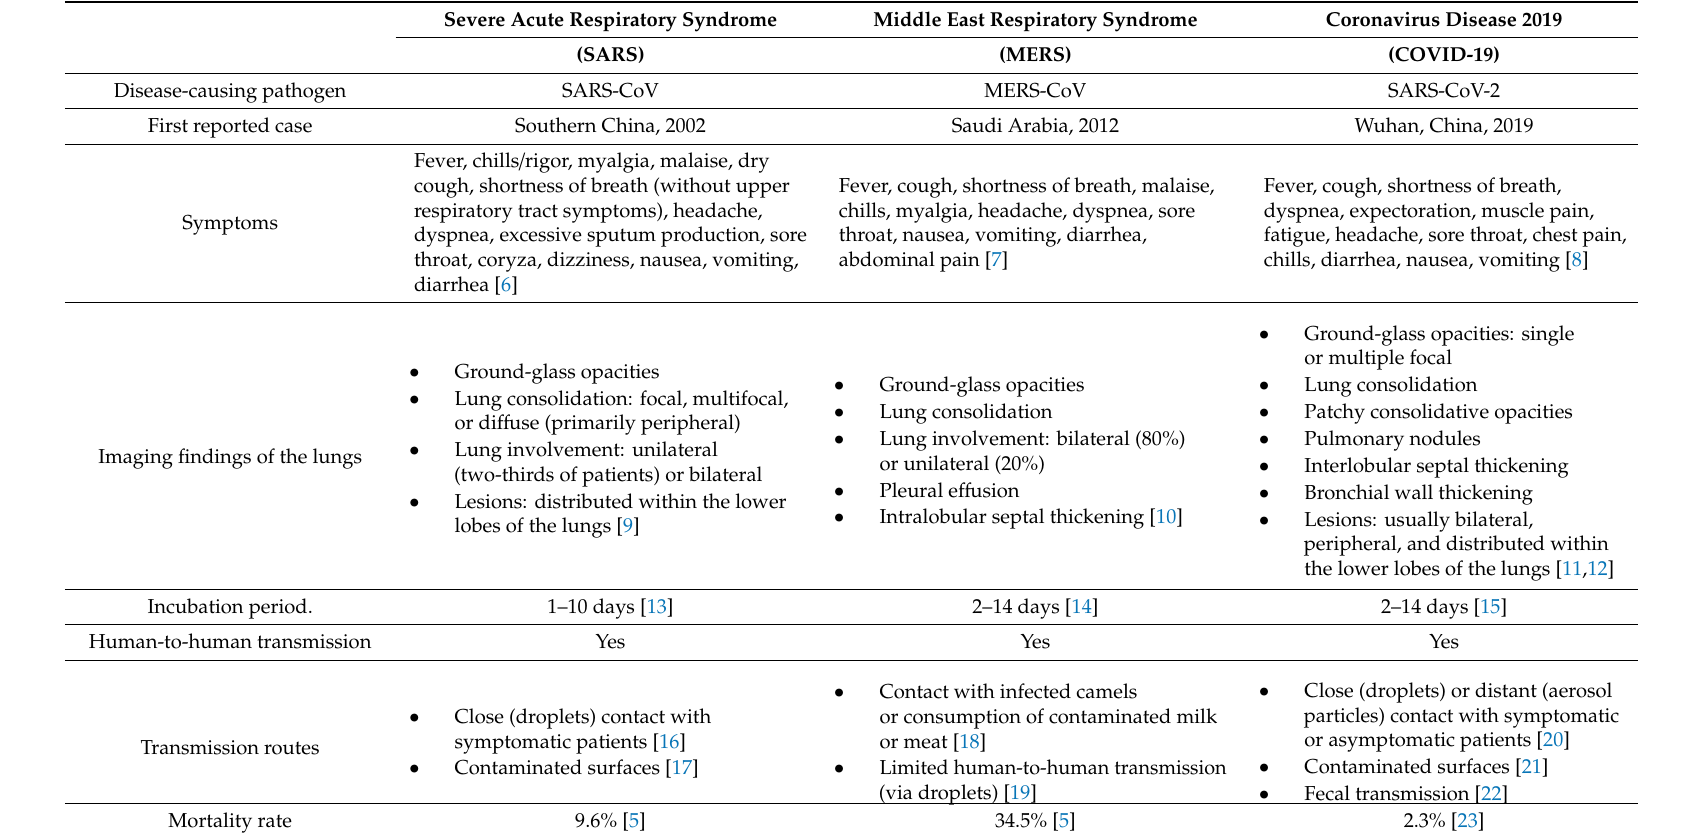
Table 1. Clinical features of severe acute respiratory syndrome coronavirus (SARS-CoV), Middle East respiratory syndrome coronavirus (MERS-CoV), and severe acute respiratory syndrome coronavirus-2 (SARS-CoV-2